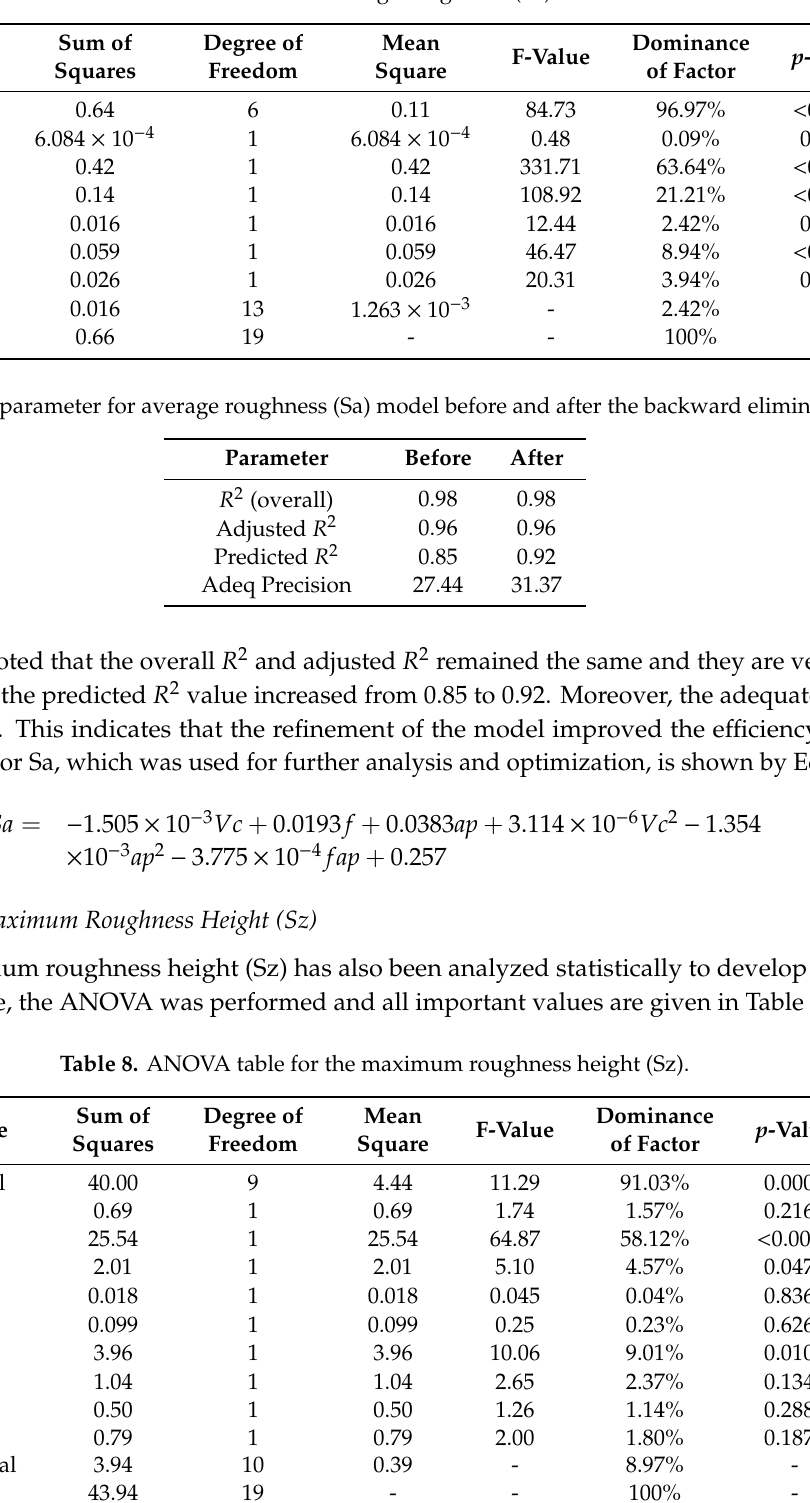
Table 6. Table of ANOVA for average roughness (Sa) after refinement.